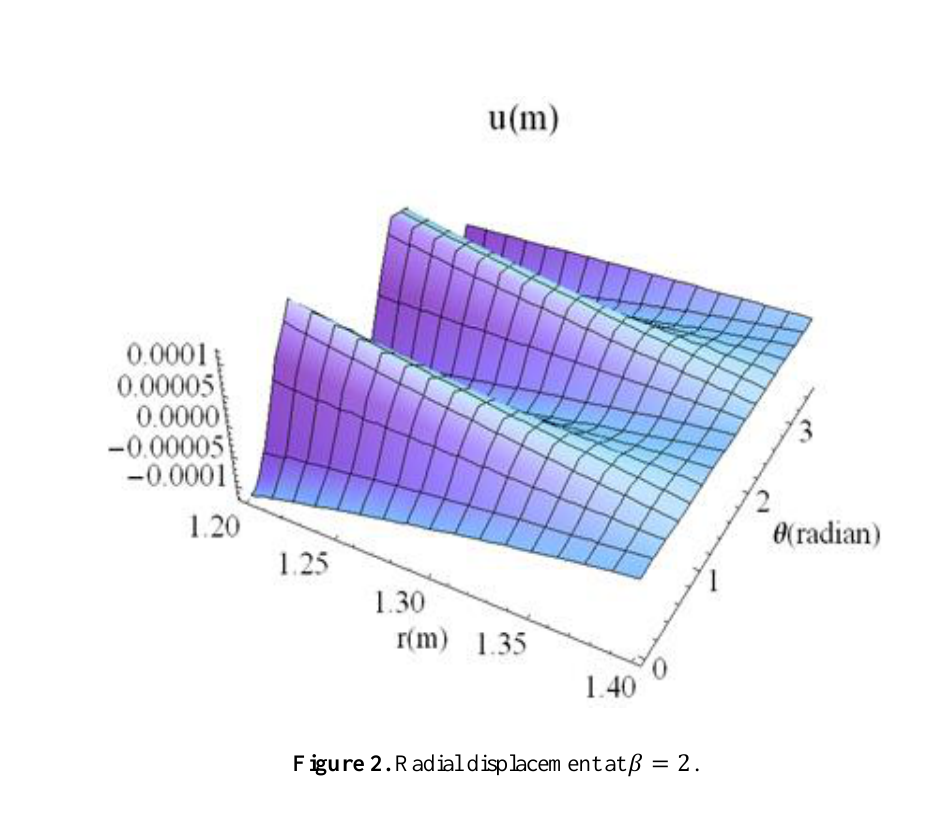
Figure 2. Radial displacement at 𝛽 = 2 .